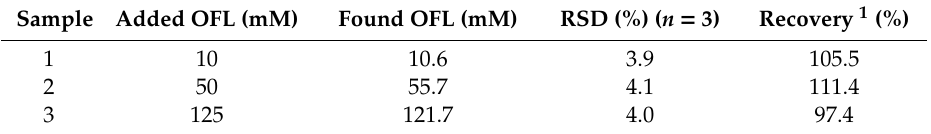
Table 1. Analysis of spiked milk samples using the developed FRET apta-assay. Sample Added OFL (mM) Found OFL